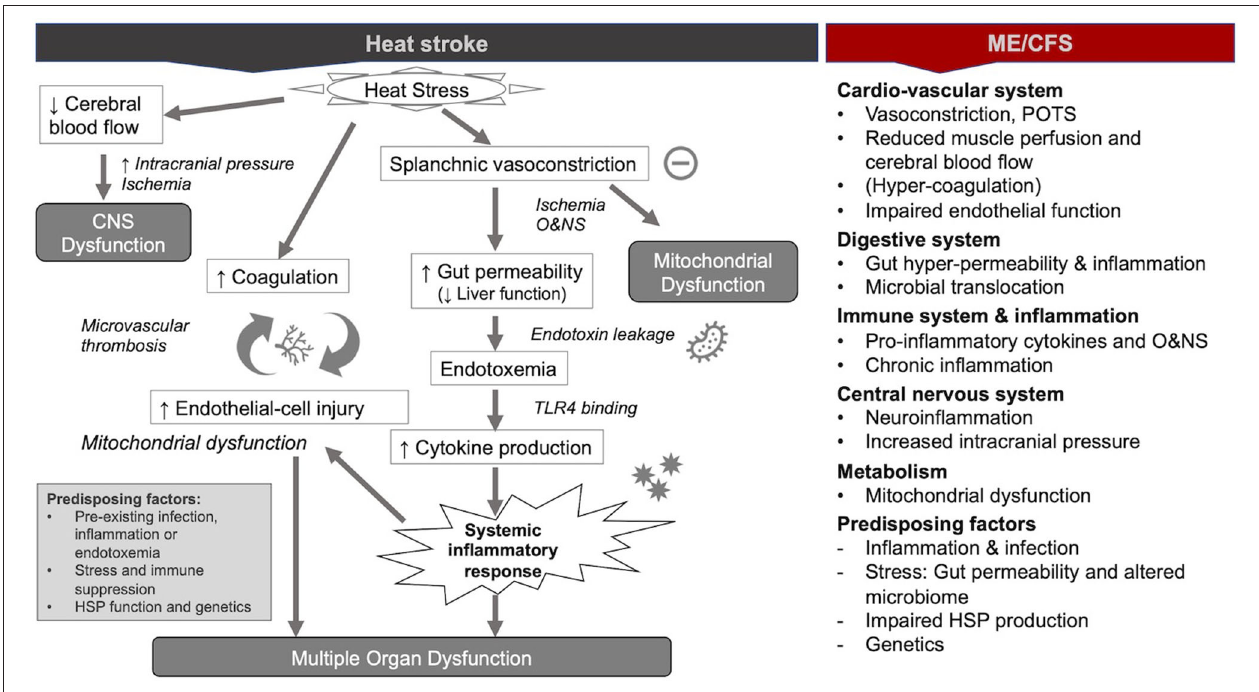
FIGURE 1 | Pathophysiological mechanisms during heat stroke and similar mechanisms in myalgic encephalomyelitis/chronic fatigue syndrome ME/CFS [modified from